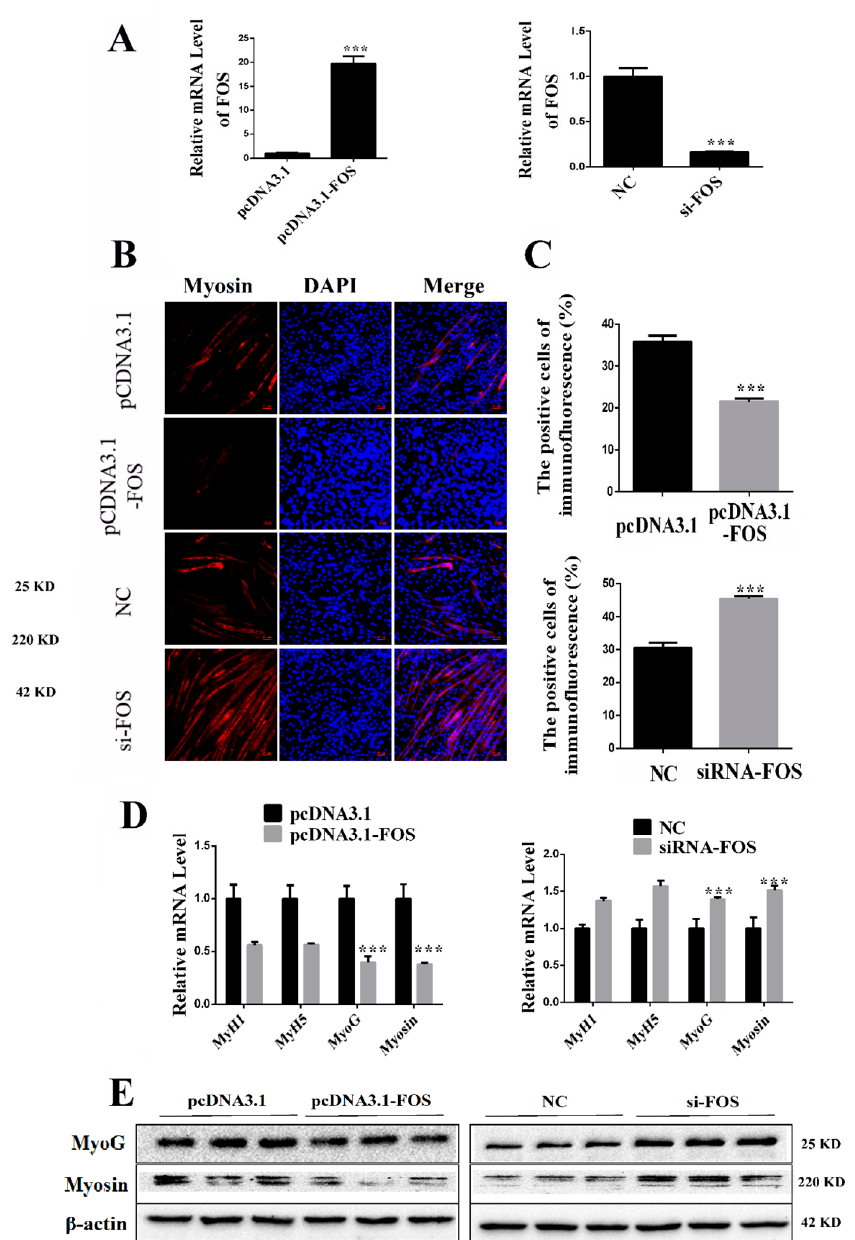
Figure 6. Overexpressing FOS inhibits C2C12 di ff erentiation. ( A ) Overexpressing or inhibiting FOS expression through transfecting C2C12 with pcDNA3.1( + )-FOS recombinant vector and siRNA-FOS, respectively. ( B ) Overexpressing FOS decreased the percentage of Myosin-positive C2C12, and interfering FOS increased the percentage of Edu-positive C2C12. Representative images of the immunofluorescent staining for di ff erentiated C2C12 are shown. Myosin: red, a molecular marker of myogenesis; DAPI: blue, cell nuclei; Merge: the C2C12 fused into primary myotubes are shown in the insets. ( C ) The quantitative data of Myosin-positive C2C12 in Figure 6B. ( D ) qRT-PCR confirmed the mRNA level of myogenic marker genes in C2C12 transfected with pcDNA3.1( + )-FOS recombinant vector and siRNA-FOS, respectively. ( E ) We used Western blot to measure the protein level of myogenic marker genes after di ff erentiation induction. Western blot result shows that the protein level corresponded to the mRNA result after di ff erentiation induction. *** p < 0.01. The results are presented as mean ± S.E.M. of three replicates for each group. Magnification 100 × . The scale bars on the photomicrographs represent 50 µ m.